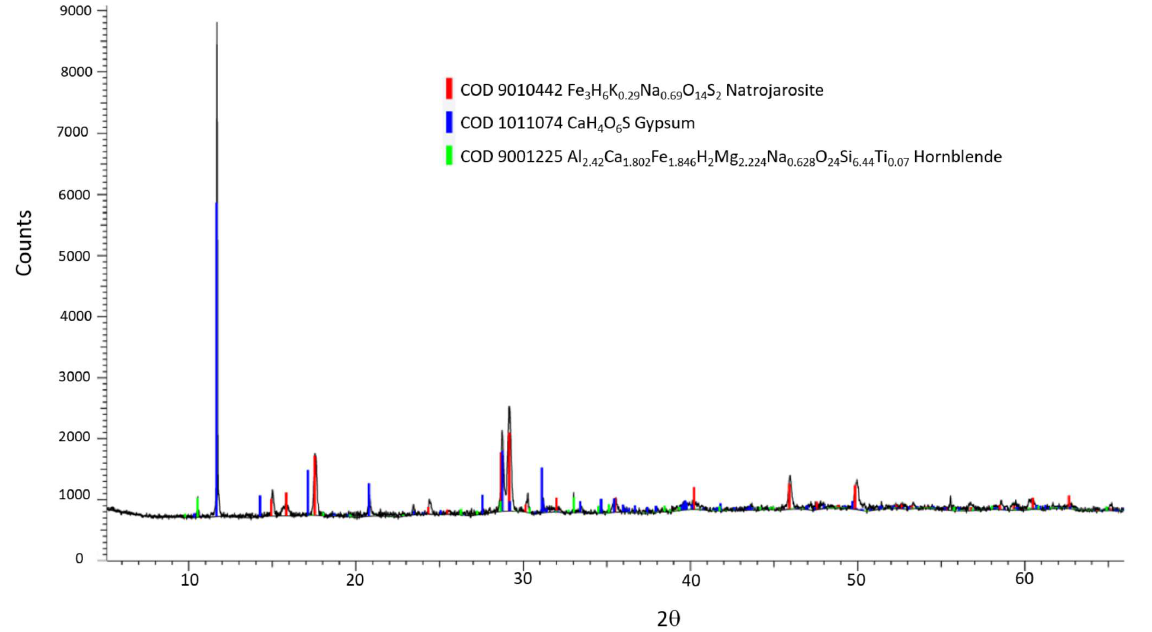
Figure 19. XRD diffraction pattern acquired from a weathering jarosite sample of Stefføya. The inset shows some of the minerals identified using Crystallography Open Database (COD). Gypsum is the major component along with natrojarosite. The co-existence of jarosite and natrojarosite is also implied from the X-ray diffraction patterns of other samples from Stefføya. Hornblende is part of the rock on which the jarosite was formed.